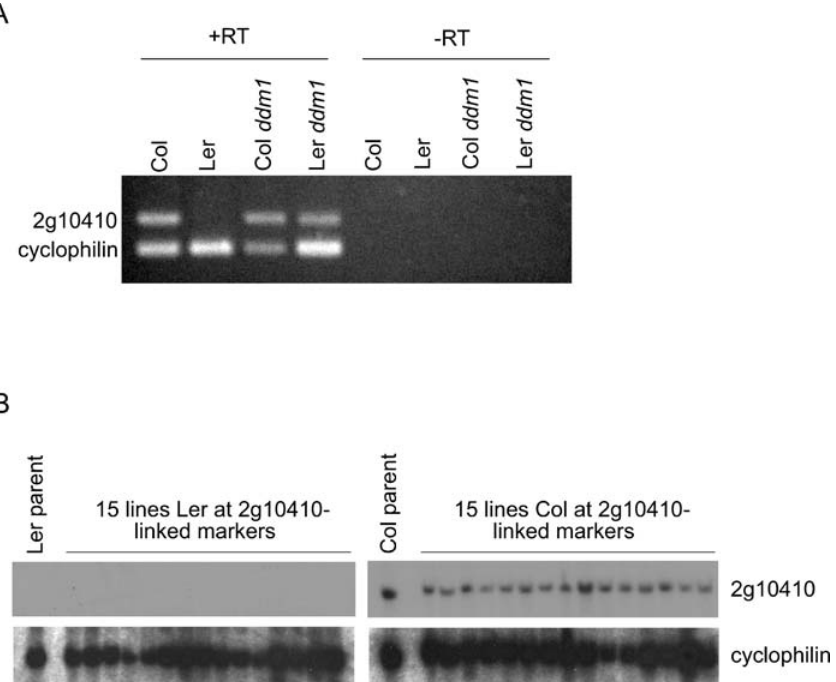
Figure 1. At2g10410 Is Differentially Expressed in the Arabidopsis Accessions Col and Ler (A) RT-PCR of At2g10410 expression in Col, Ler, Col ddm1–1, and Ler ddm1–2 . Cyclophilin is shown as an internal control for amplification. (B) RNA gel blots of Col/Ler recombinant inbred lines. Lines homozygous for Col alleles at At2g10410 -linked markers express the locus, while lines homozygous for Ler alleles at linked markers do not express At2g10410 . All lanes were included on the same filter. The filter was rehybridized with a cyclophilin probe as a loading control. DOI: